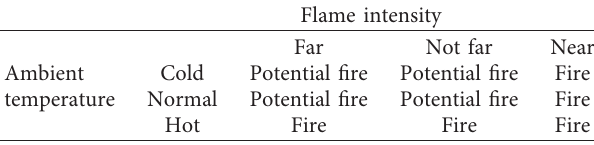
Table 3: Rules for fire status when smoke is high.